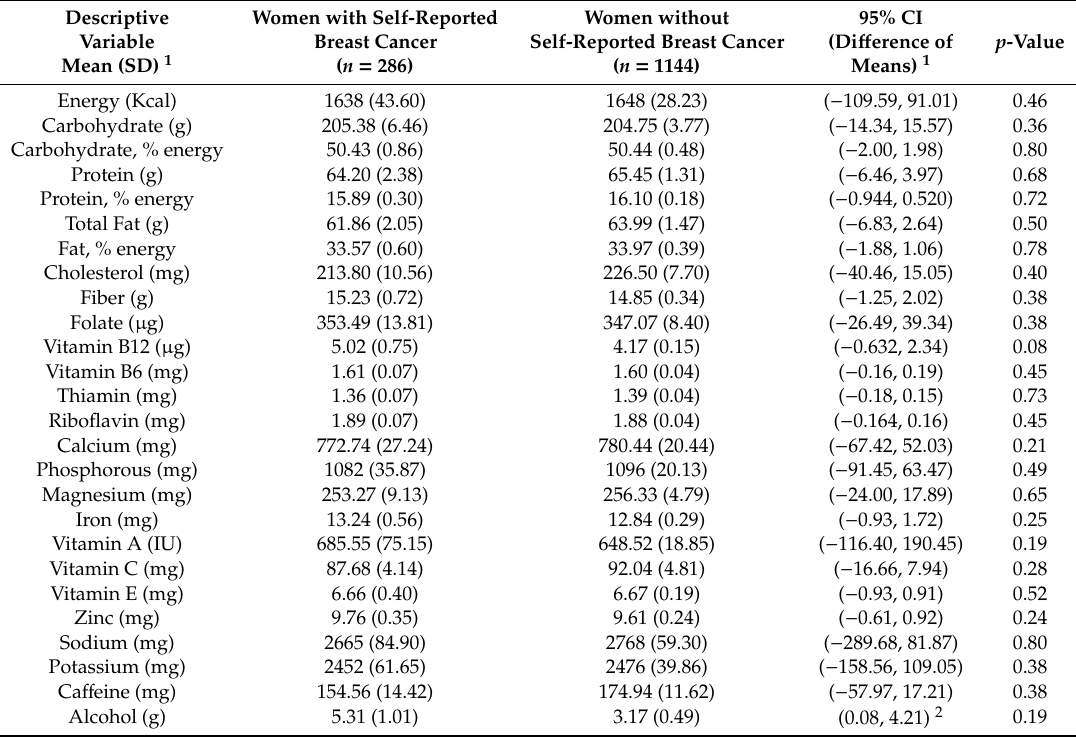
Table 2. Dietary macro- and micronutrient intakes in women with and without self-reported breast cancer. Descriptive